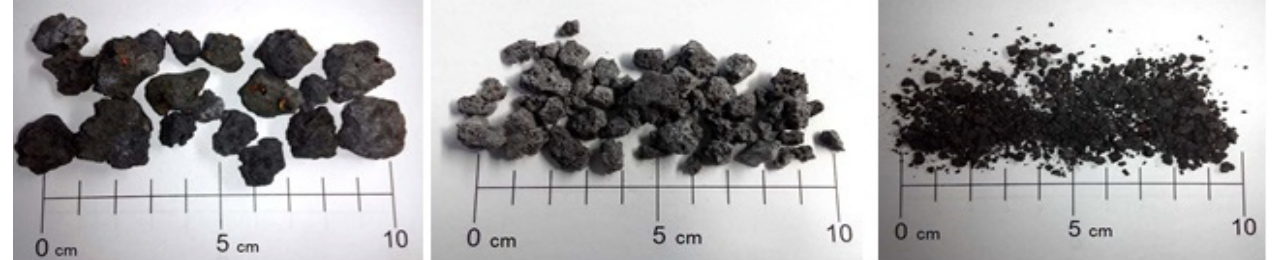
Figure 2. EAFS used in the study, provided in three grading sizes.